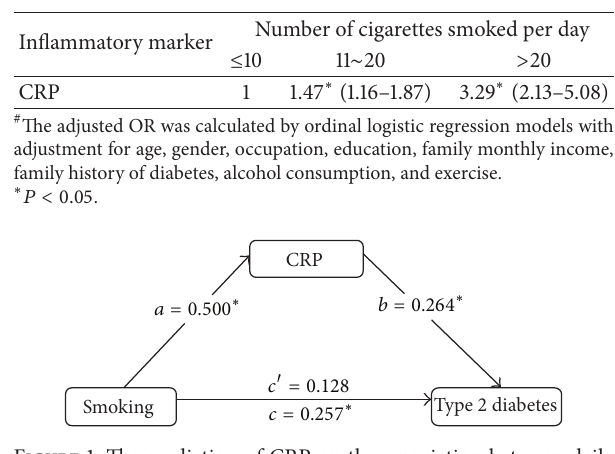
Figure 1: The mediation of CRP on the association between daily smoking quantity and type 2